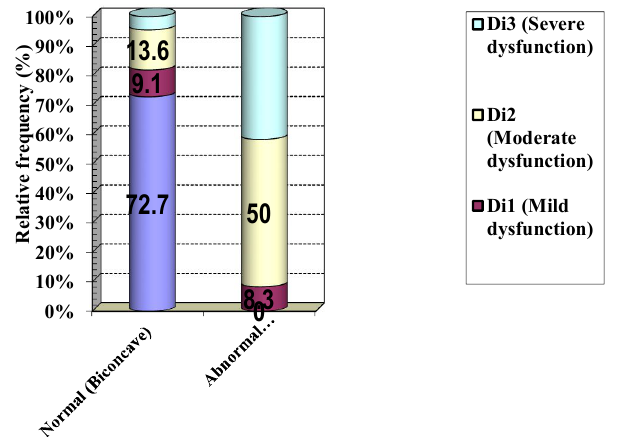
Figure 2: Correlation between Helkimo clinical dysfunction index and MRI findings of disc